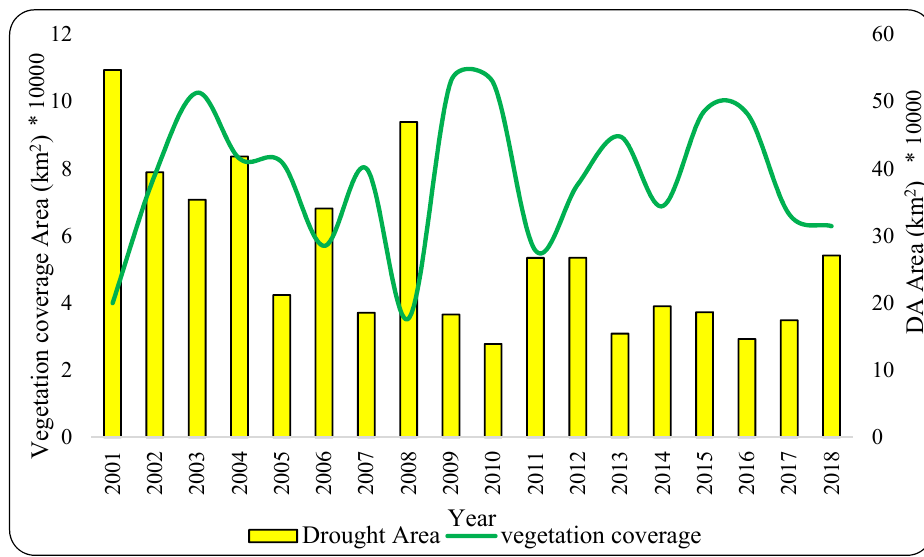
Figure 5. The relationship between vegetation coverage area and areas of DA and NDA in Afghanistan between 2001 and 2018. Remote Sens. 2020 , 12 , x FOR PEER REVIEW